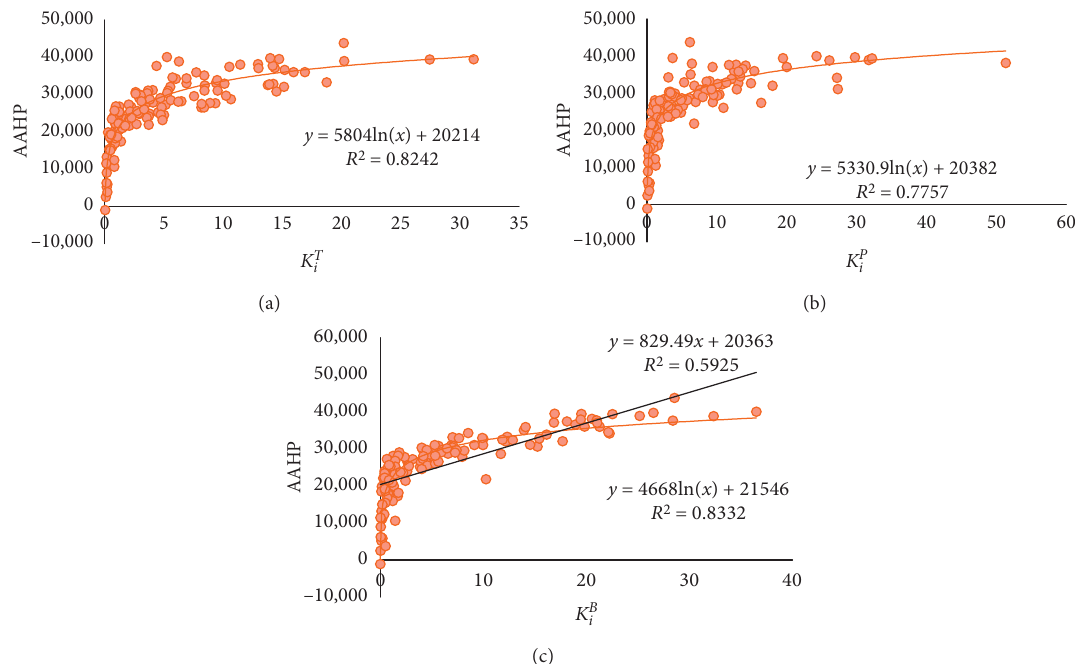
Figure 8: The Line Fit Plots of K T